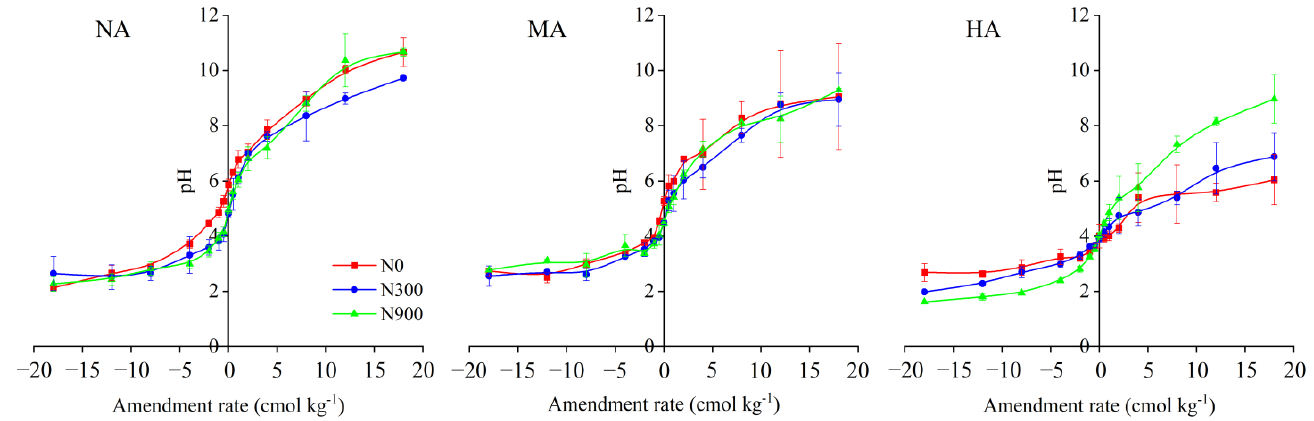
Figure 2. Titration curves with different N application rates at tea plantations with different degrees of acidification. Note: on the X axis, negative values indicate the amount of acid, and positive values indicate the amount of alkali. Table 3. Soil pH buffering capacity under different N application rates at tea plantations with different degrees of acidification.